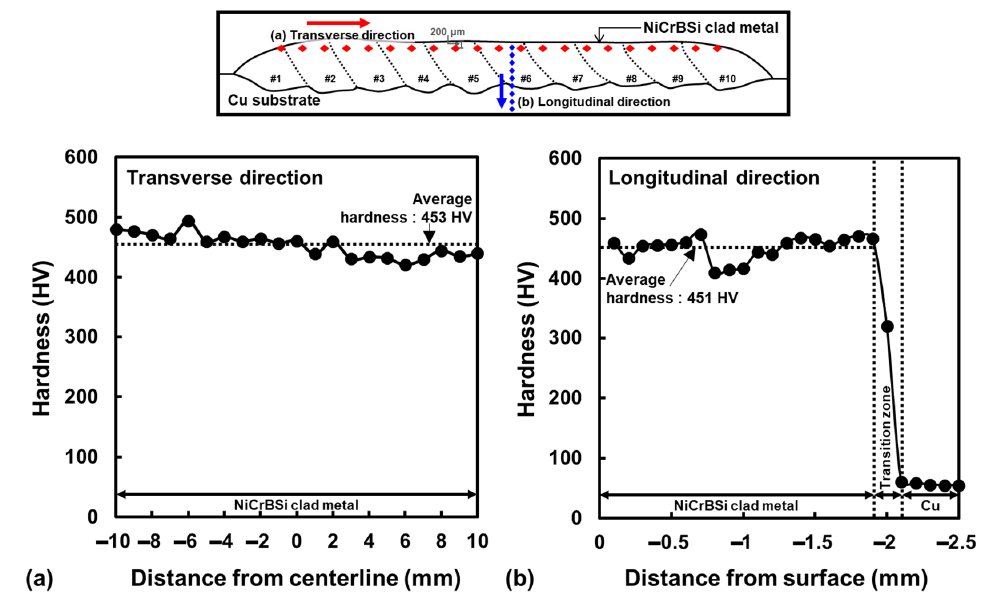
Figure 5. Hardness distribution in the ( a ) transverse and ( b ) longitudinal directions for an as-clad specimen.